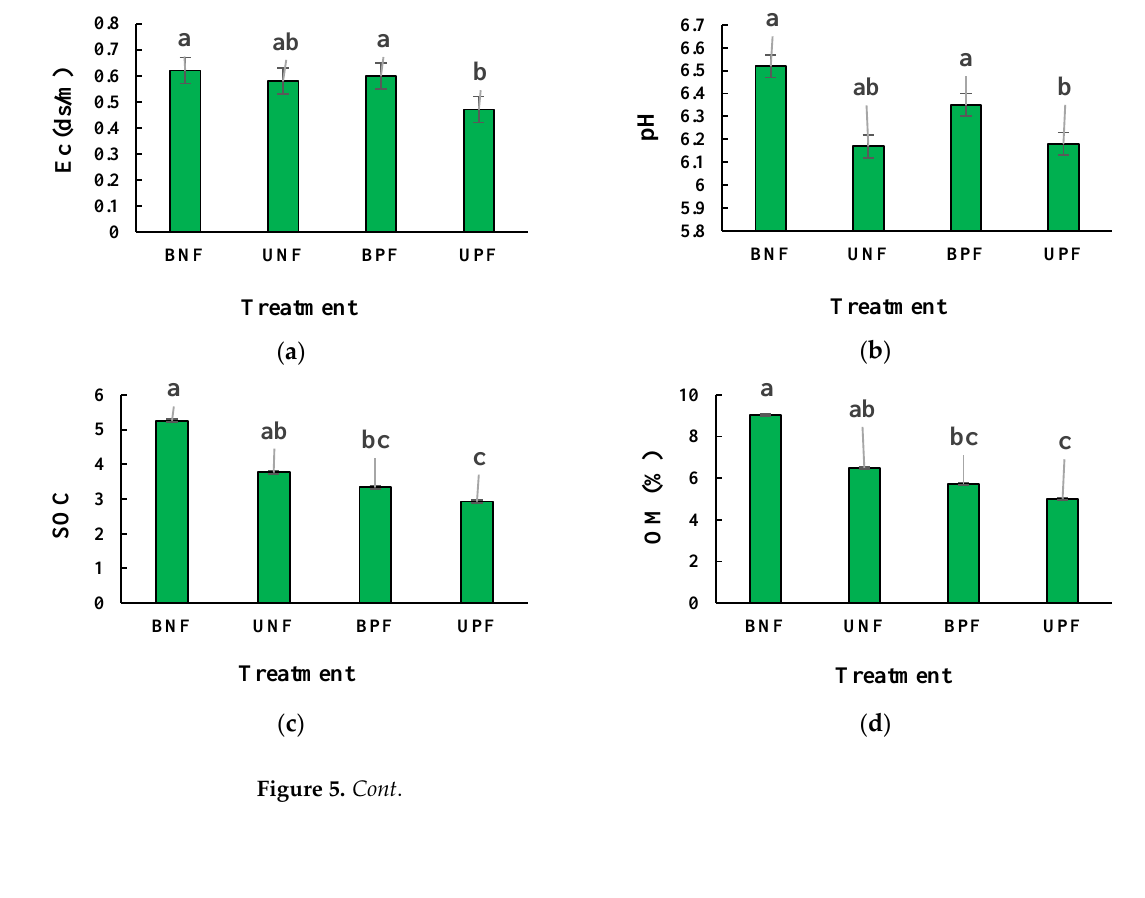
Table 4. Two-way analysis of variance of soil chemical properties in fire and non-fire treatments.